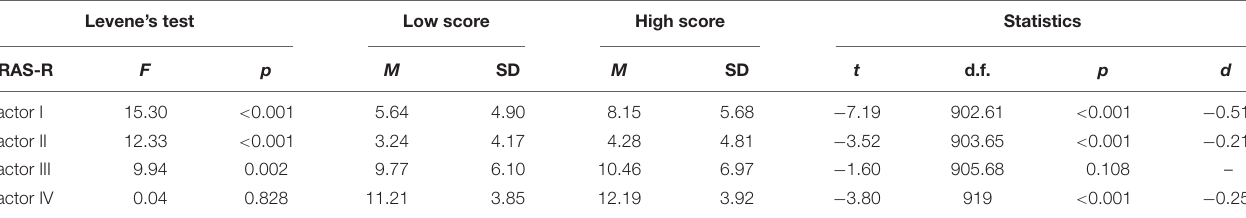
TABLE 2 | Differences in school refusal behavior in students with high and low scores on Physical Aggression. Levene’s test Low score High score